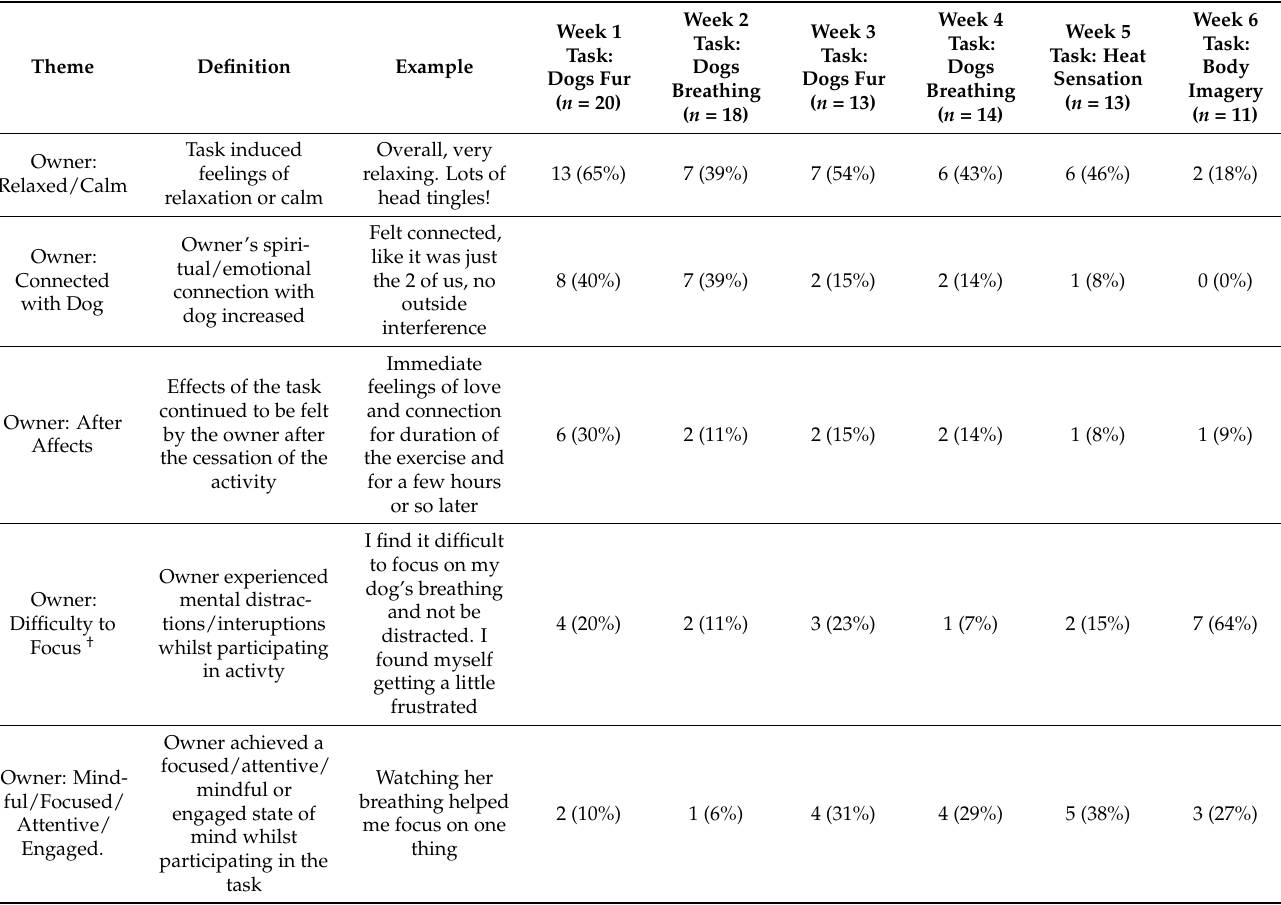
Table 7. Most frequently endorsed themes relating to the dog assisted mindfulness groups weekly task